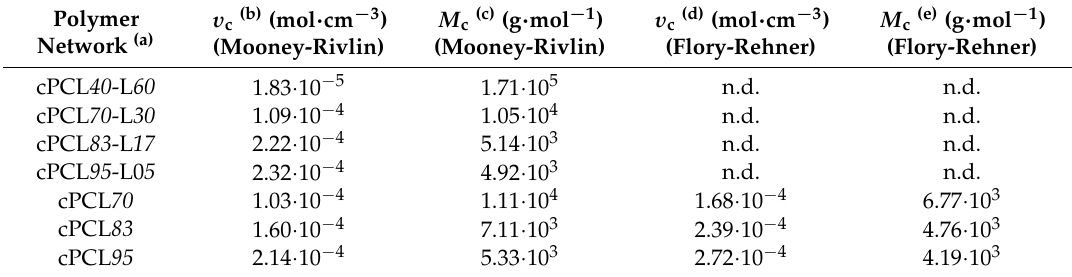
Table 2. Summary of physical properties of cPCL networks concerning the crosslinking density and the molecular weight between